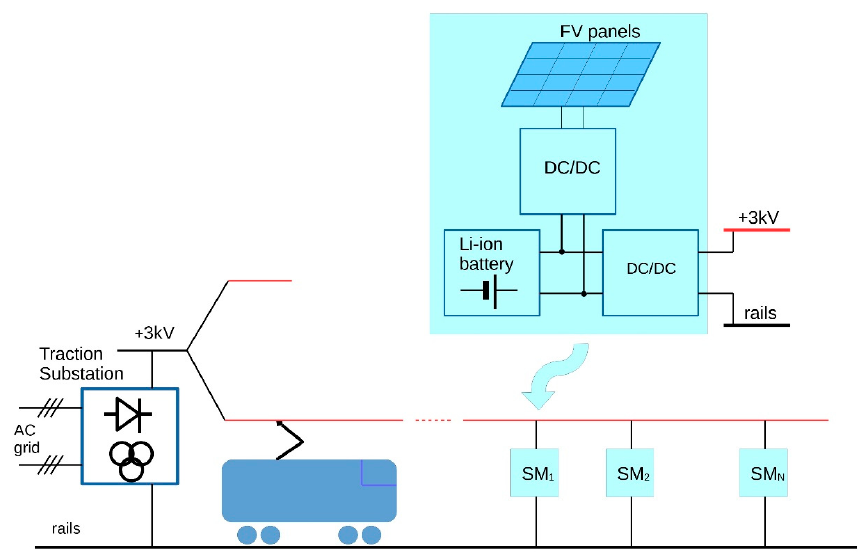
Figure 1. The concept of the proposed supplying system with a simplified scheme of a single feeding module.